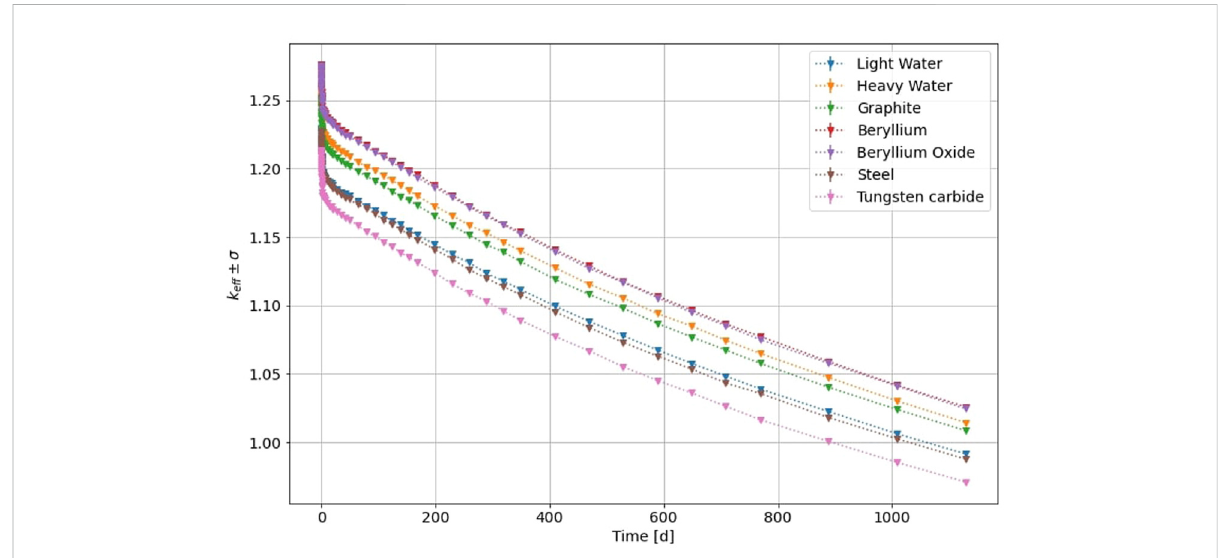
FIGURE 10 The comparison between k eff variations of normal SMART with different re fl ector materials.